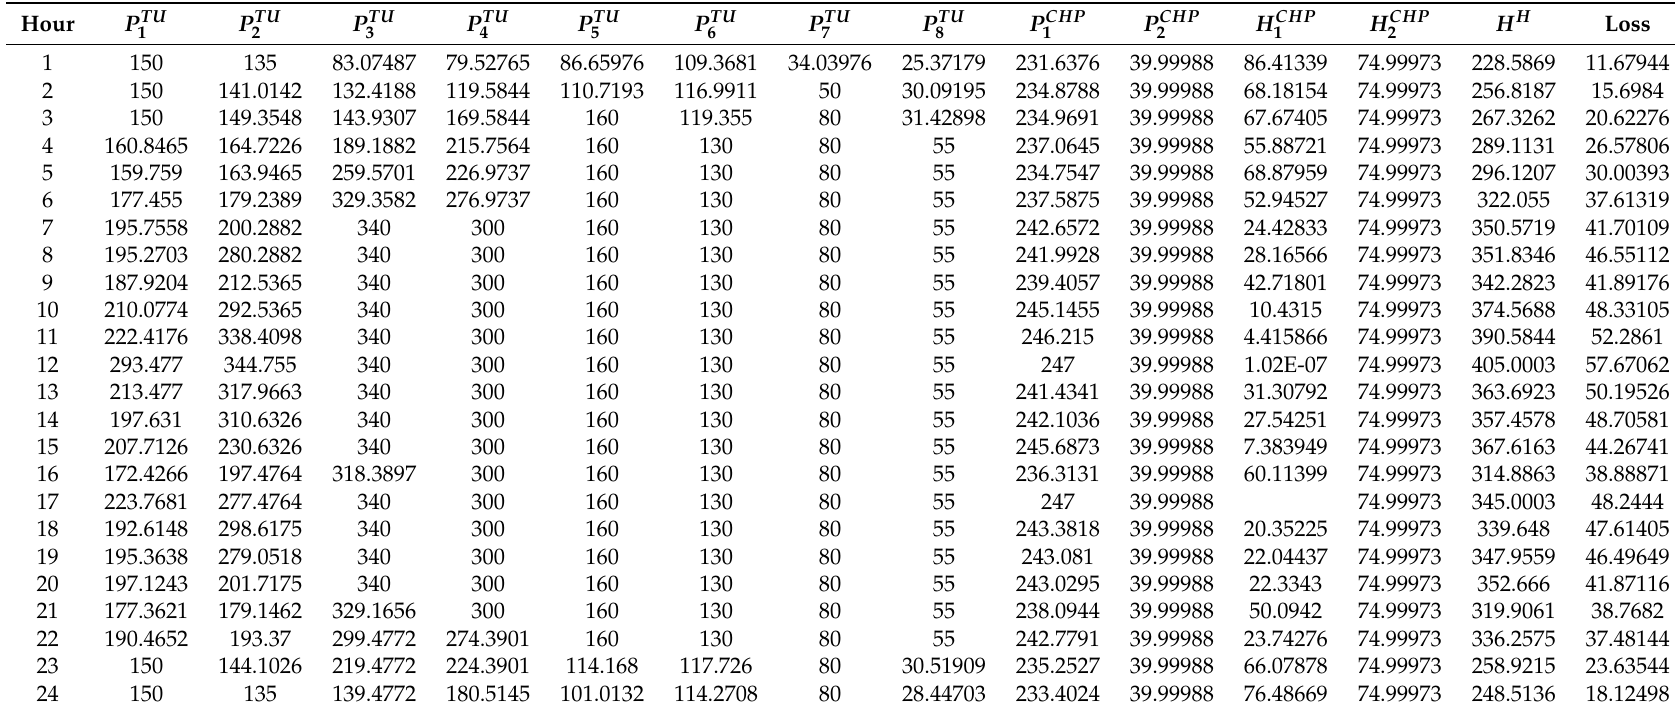
Table A7. Detailed power flow results for Case